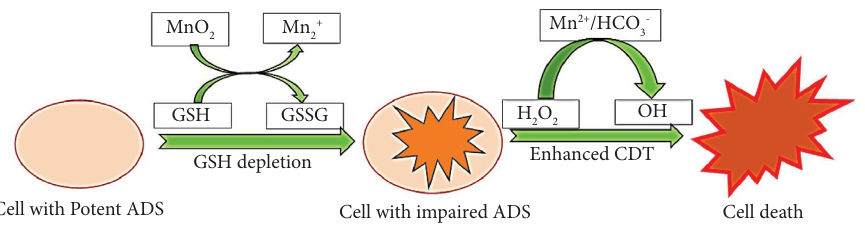
Figure 11: Cancer treatment through nanoparticle-facilitated Fenton